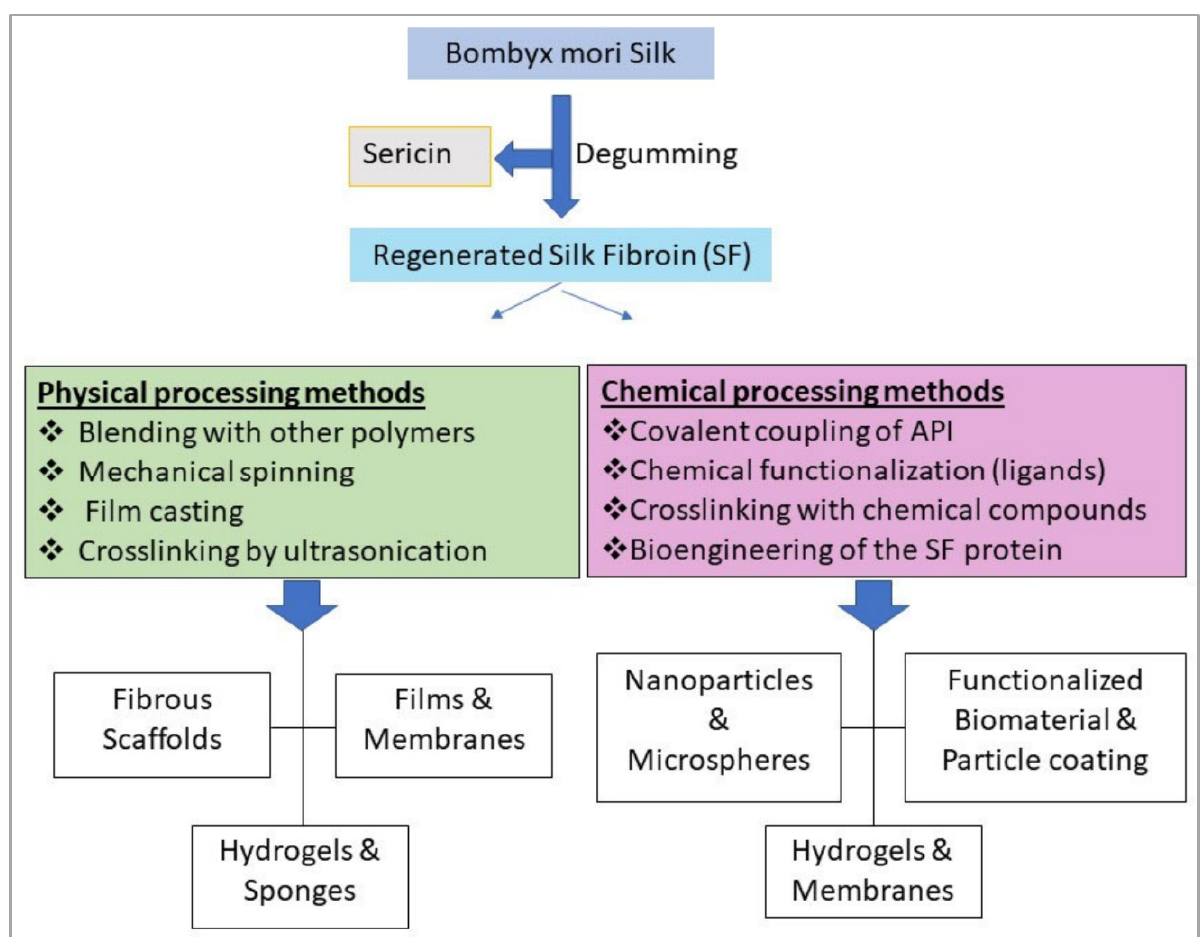
Figure 1. For pharmaceutical and biomedical implementations, a versatile range of functional arrangements and chemical treatment for manufacturing a variety of silk fibroin (SF) formats are available. Image reproduced from reference [39] which was published under a CC BY license.